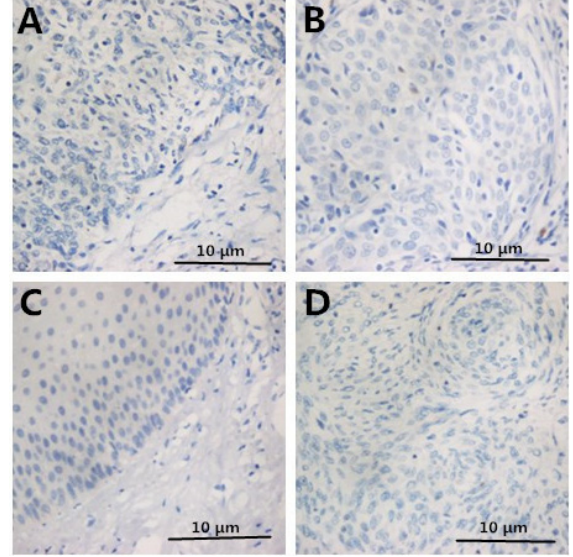
Figure 2. Negative control staining of HMGB1, FOXP3, IL-2, and IL-10 is displayed in sub-figures A – D